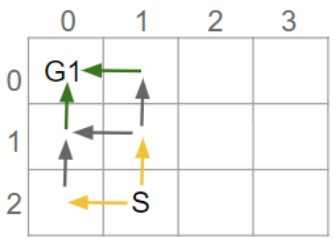
Figure 8. A depiction of the grid-based navigation problem, that used to describe the Action Graph creation algorithm. The arrows indicate the actions within the produced Action